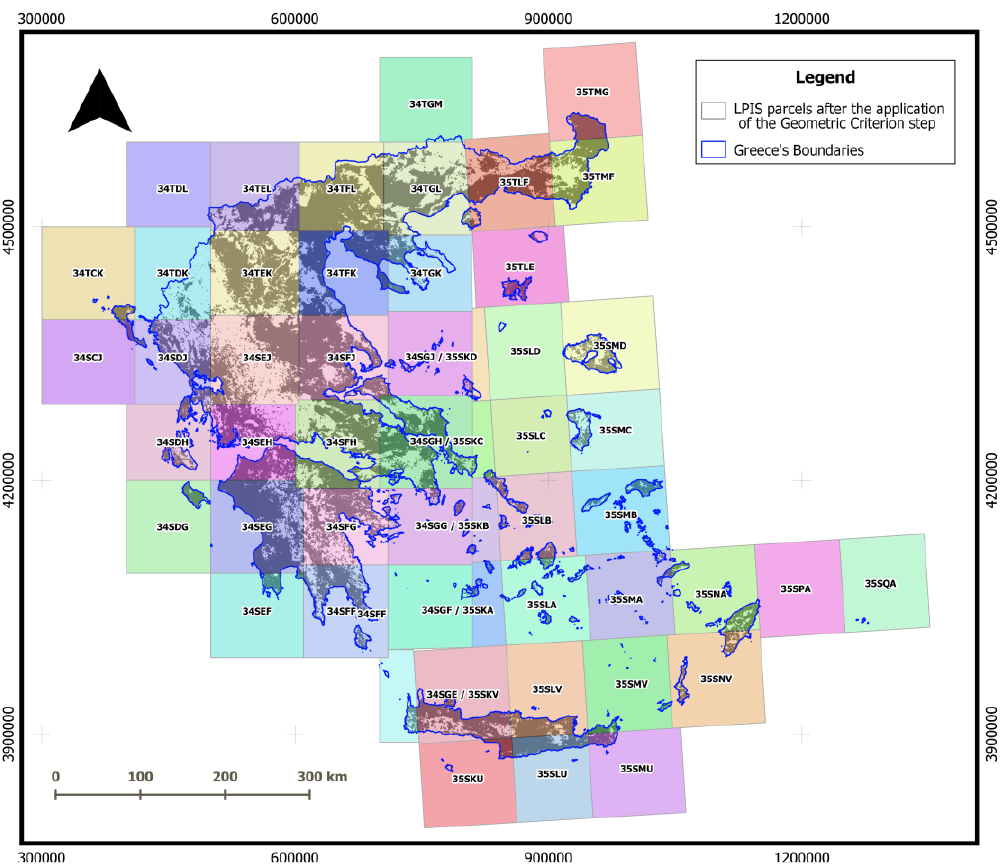
Figure 1 . The distribution of the filtered parcels after the application of the geometric criterion overlaid by the Sentinel-2 tighter boundaries’